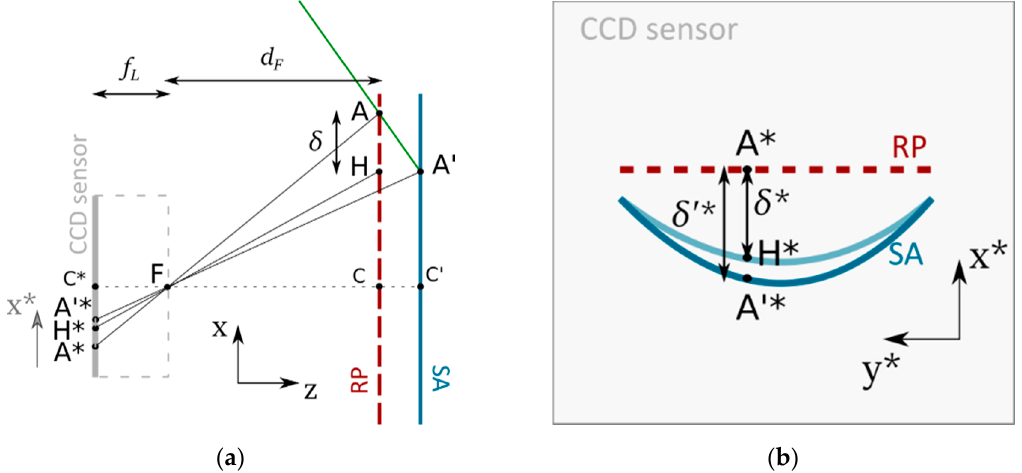
Figure 6. ( a ) Scheme of the geometry behind the reconstruction formula. ( b ) Definition of the deformation, as the distance between the line projected on RP (red line) with respect to that projected on SA (blue line).